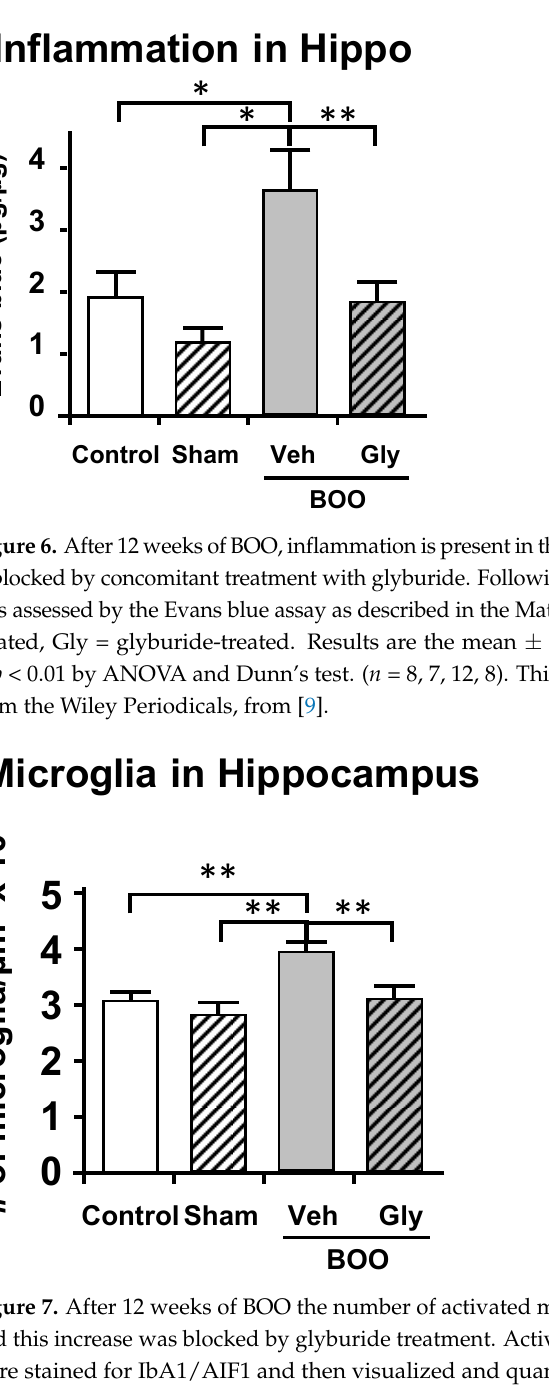
Figure 8. After 12 weeks of BOO, neurogenesis is statistically decreased in the hippocampus and this increase is blocked by glyburide treatment. Cells in 10 μ m sections of brain were stained for Ki ‐ 67 and then visualized and quantitated as described in the Materials and Method section. The results are presented as the density of Ki ‐ 67+ cells per μ m 2 . Veh = vehicle ‐ treated, Gly = glyburide ‐ treated. Results are the mean ± 95% confidence intervals; * p < 0.5 and ** p < 0.01 by ANOVA and Dunn’s test. ( n = 6, 6, 6, 6). This figured was reprinted, with permission from the Wiley Periodicals, from [9].